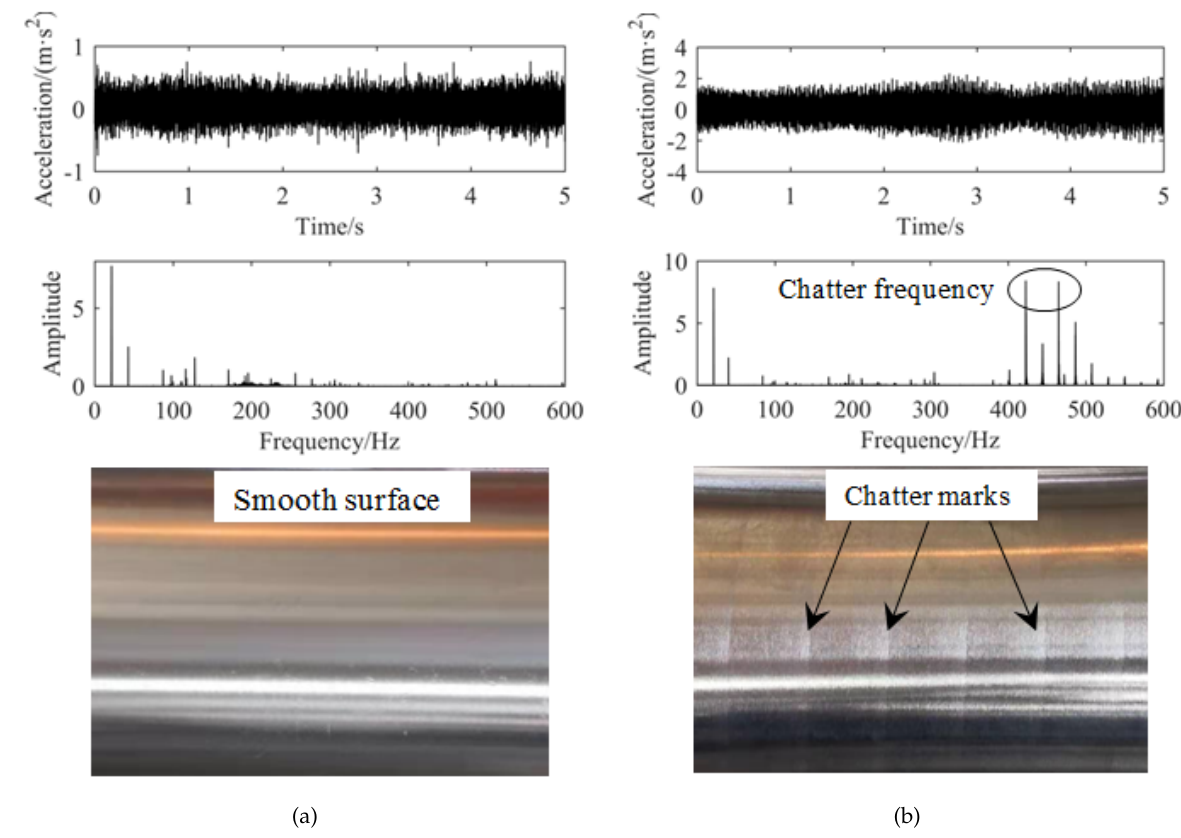
Fig. 5. (a) Acceleration signal and the corresponding frequency spectra and ground surface for case A. (b) Acceleration signal and the corresponding frequency spectra and ground surface for case B